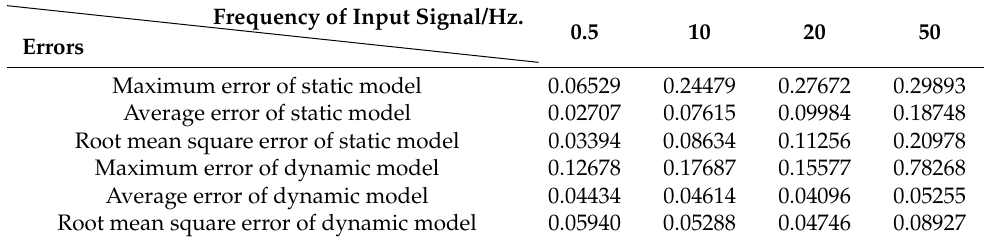
Table 2. Error of hysteresis model under different excitation signal frequencies. Frequency of Input Errors